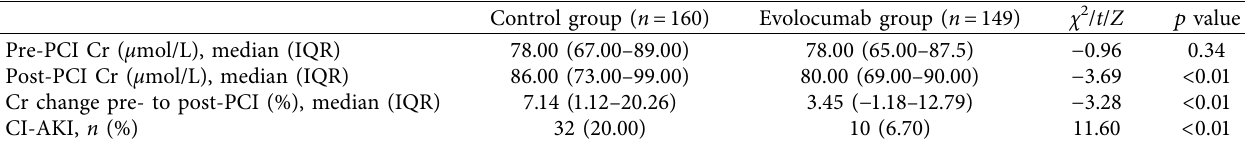
Table 2: Comparison of pre- and postintervention kidney function and contrast-induced acute renal injury between those who received evolocumab and